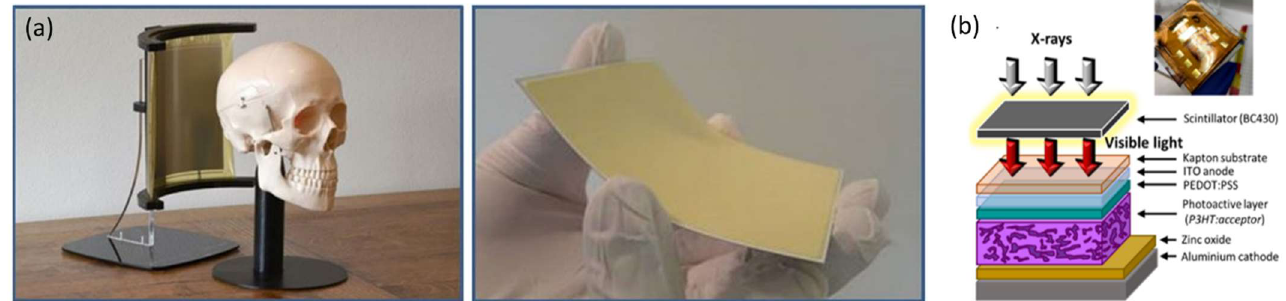
Figure 13. ( a ) Prototype of curved image sensor, Reprinted with permission from [38] ©2020 Nature Portfolio and ( b ) layered device architecture employed in the fabricated organic photodetector devices of this study. The scintillator is employed to facilitate indirect X-ray detection for dosimetry characterizations Reprinted with permission from [ 42 ] ©2021 ACS Publications .